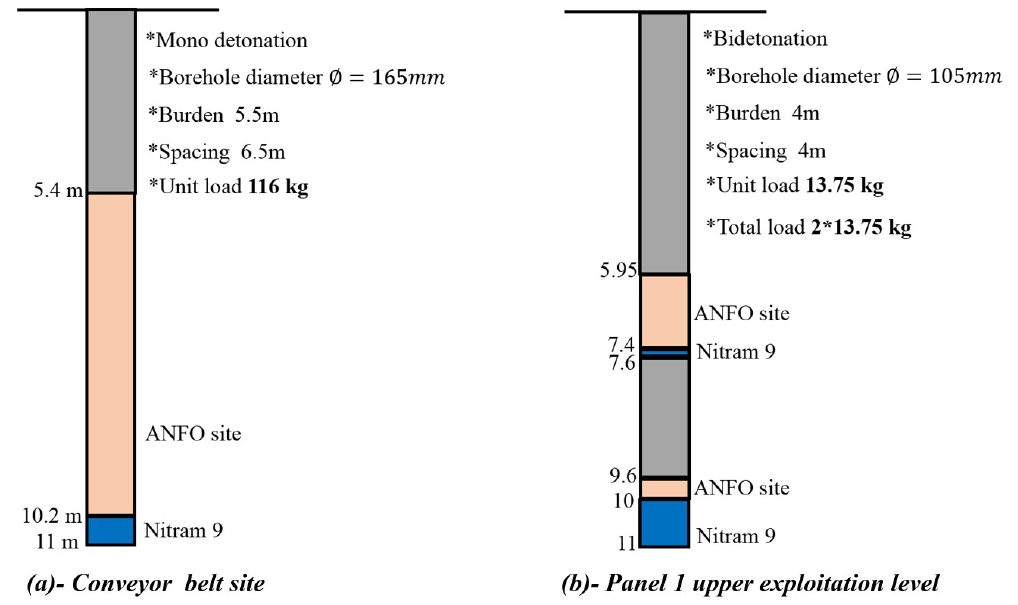
Figure 10: The blast design of charge structure in different site: (a) “Conveyor belt” site; (b) “Panel 1 (Upper exploitation level)”